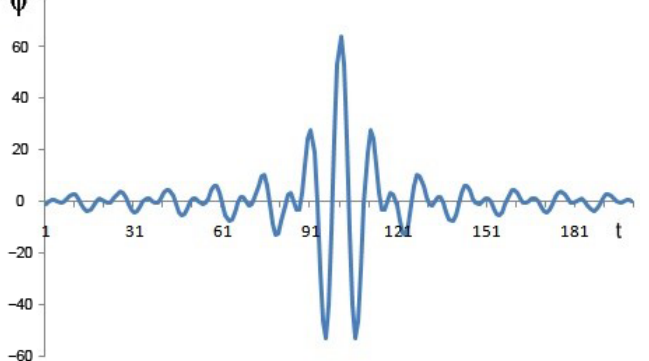
Figure 5. Orthogonal symmetric wavelet.